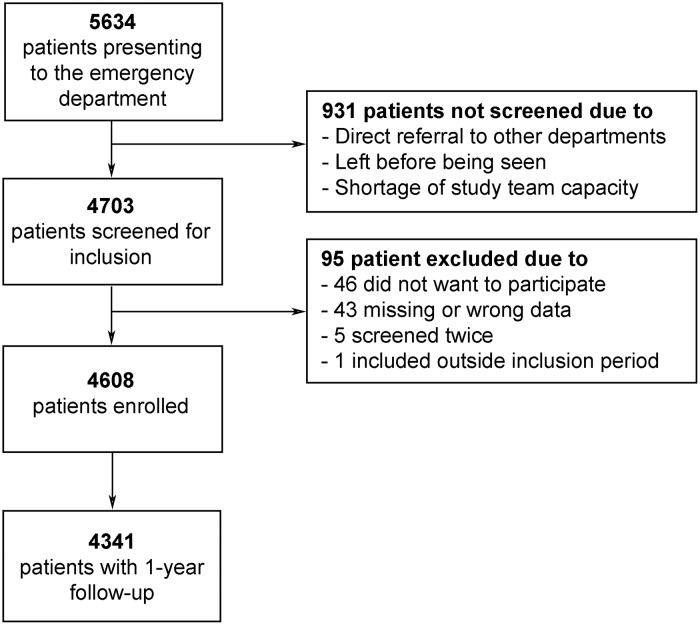
Flow diagram of enrolment.